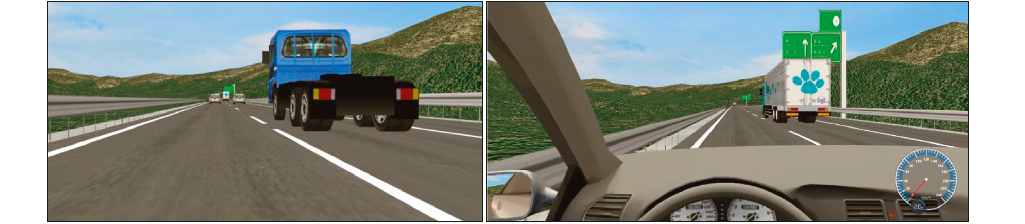
Figure 2: Test-driving scene.